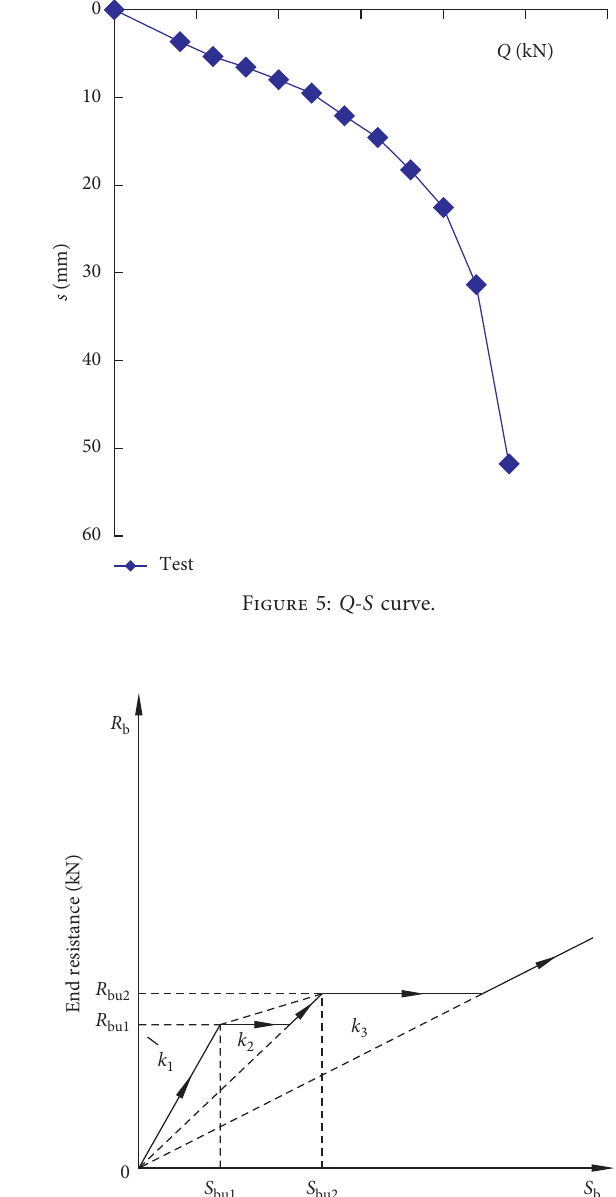
Figure 5: Q - S curve.